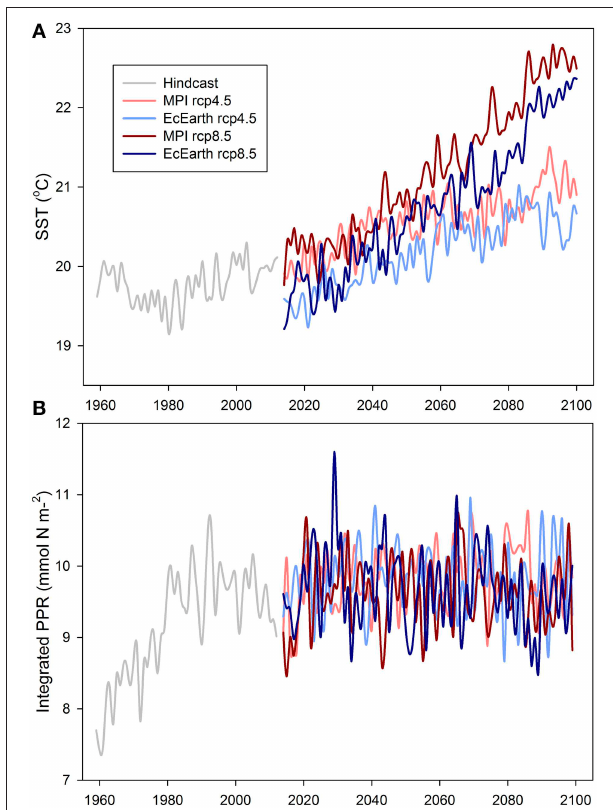
FIGURE 2 | Time series of mean (basin averaged) (A) sea surface temperature (SST) and (B) surface (50m) primary production rate (PPR) for the hindcast (gray line) and the different simulation scenarios (color